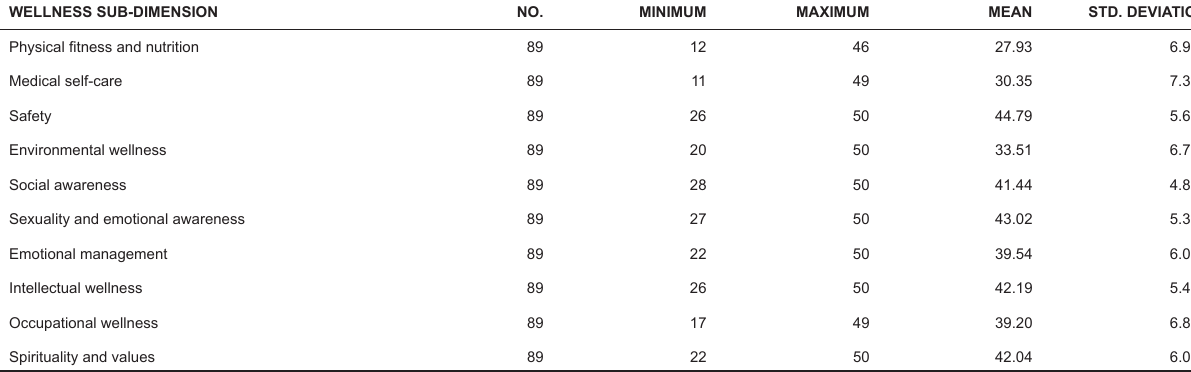
TABLE 5 Combined average wellness behaviour levels of managers at the two sample